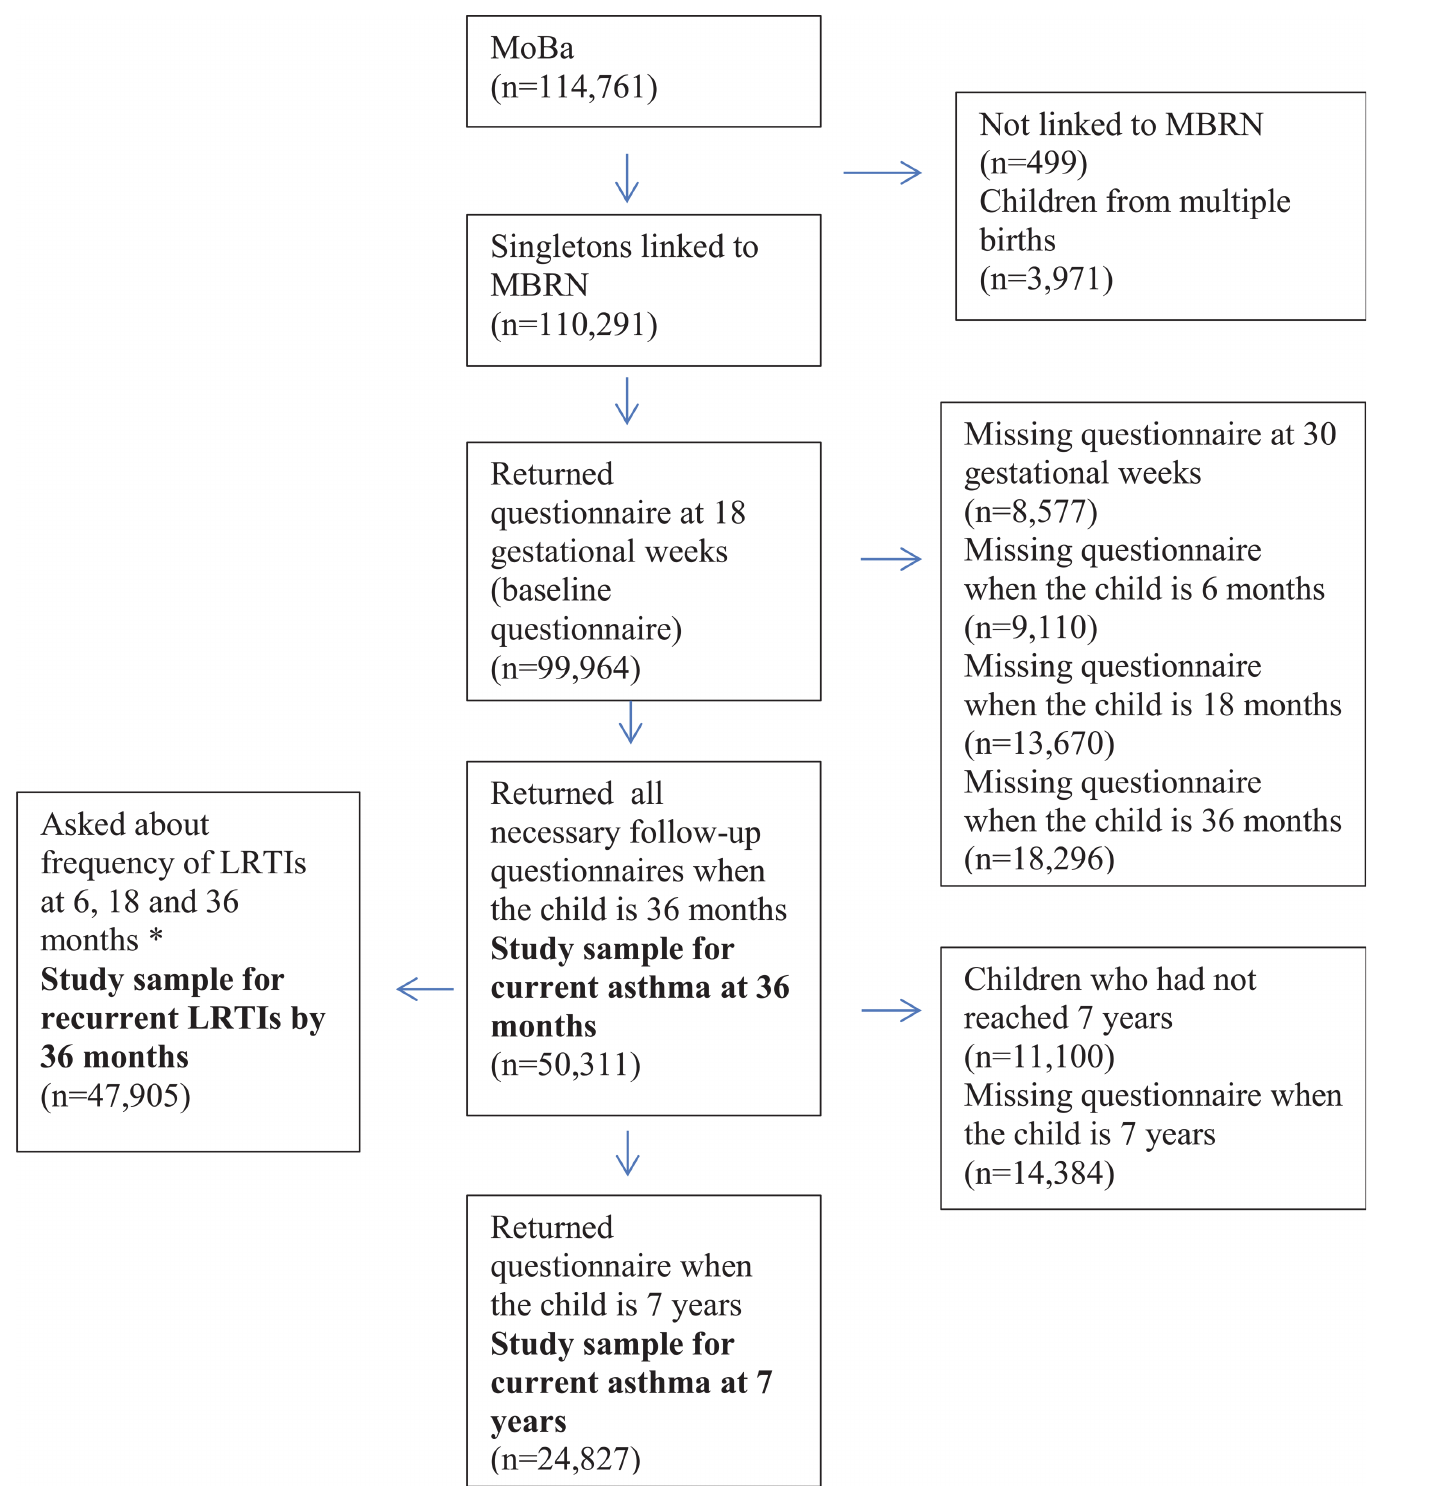
Figure 1. Illustration of sample size. LRTIs- lower respiratory tract infections. a Some versions of questionnaires did not ask about frequency/number of LRTIs.